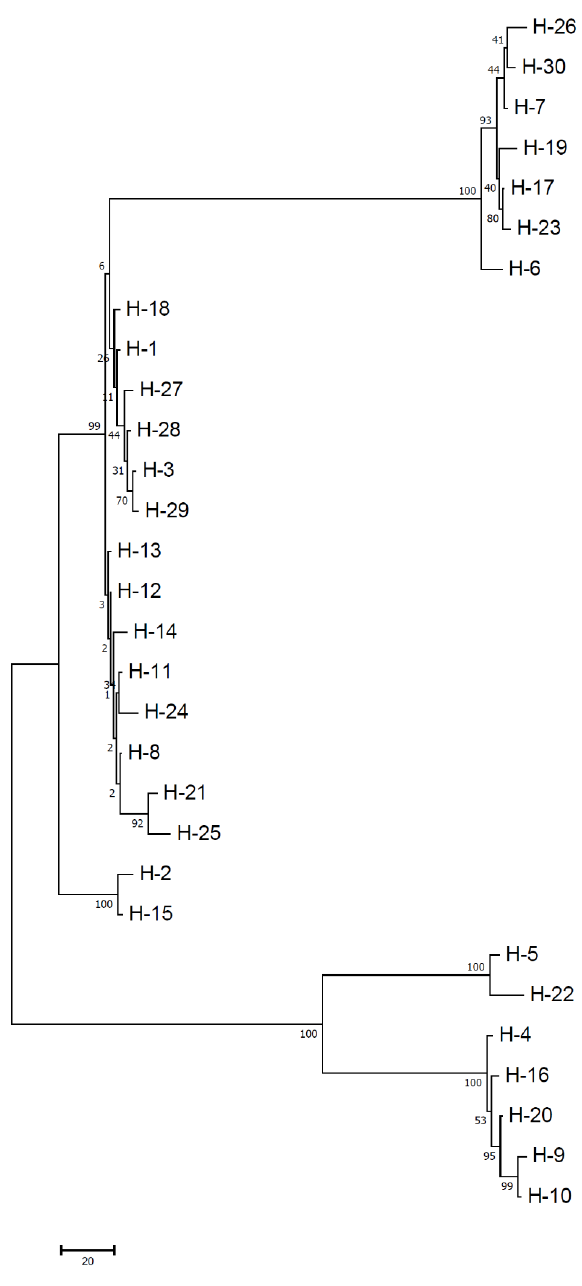
Figure 4. Unrooted maximum parsimony (MP ) tree of haplotypes.